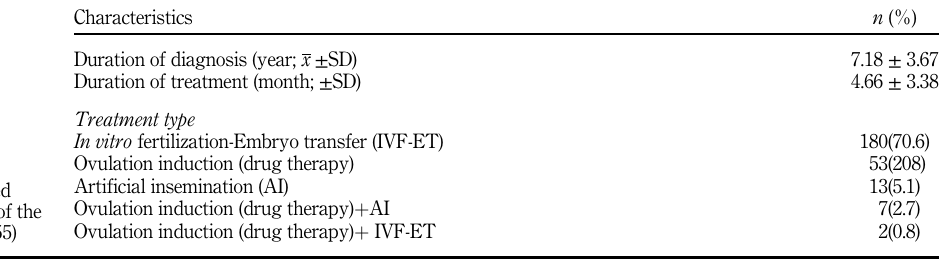
between gender perception and infertility distress of